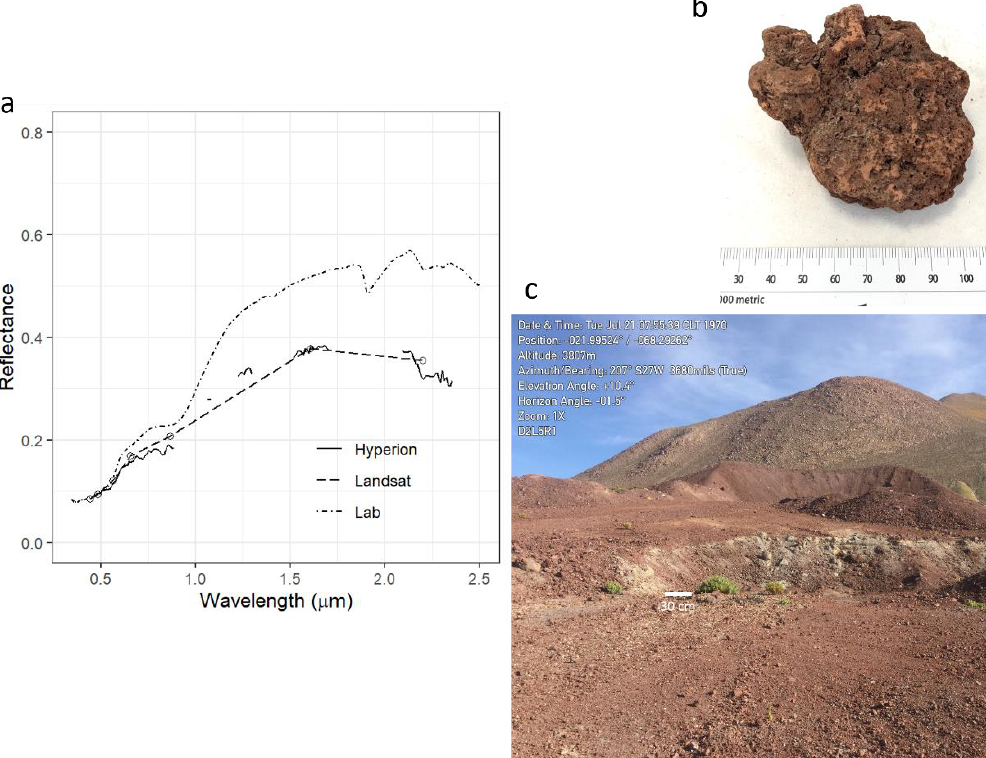
Figure 7. ( a ) Comparison of remote sensing spectra of El Rojo III location to a spectrum acquired in the laboratory of El Rojo III red scoria sample. ( b ) Image of the sample used for spectral measurement. ( c ) The view of El Rojo III scoria cone in the field (22°0 ′ 5 ″ S, 68°18 ′ 46 ″ W). Minor amounts of white minerals in ( c ) are alteration minerals, which contributed to the discrepancy of spectra in ( a ), in which the sample lacks this white mineral.